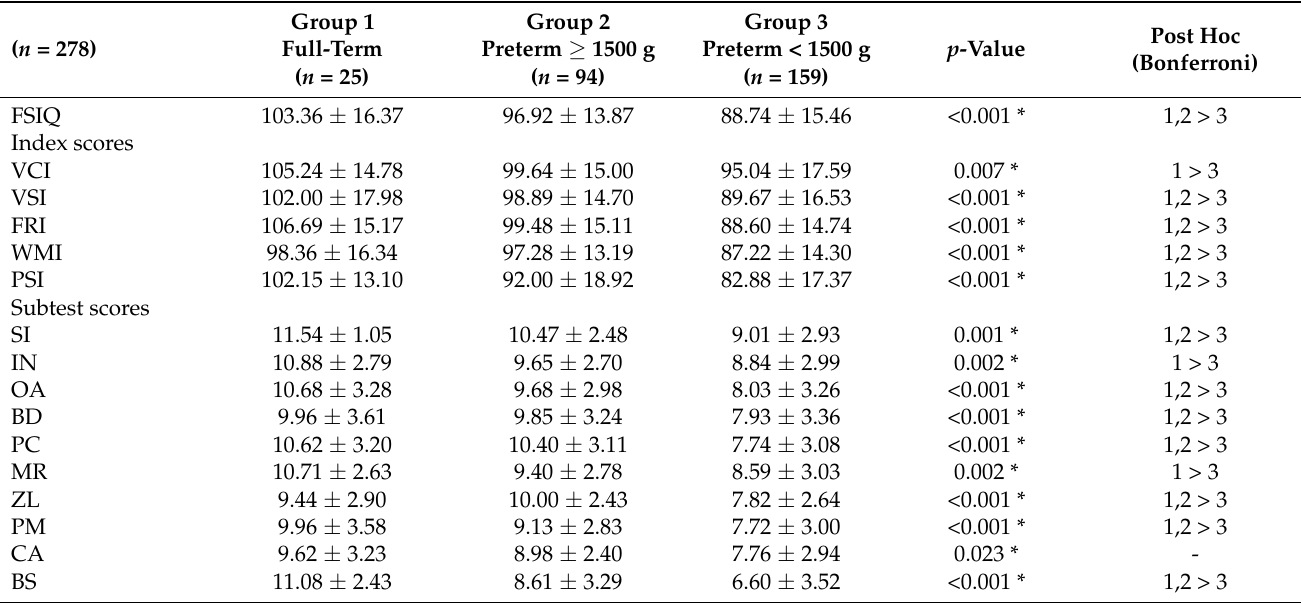
Table 3. Comparison of WPPSI-IV variables between groups after adjusting for age, GA, BPD, and